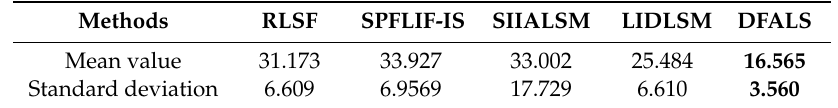
Table 3. The mean value and standard deviation of P mp given by di ff erent methods on test images in %.